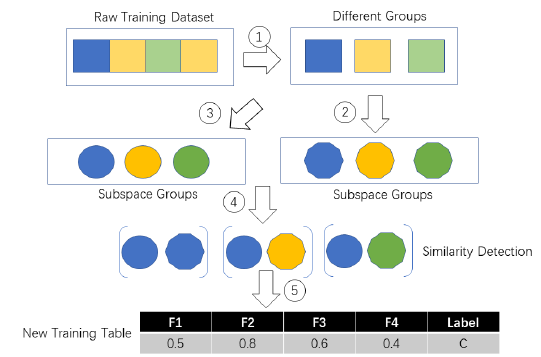
Figure 2. Process of transfering raw training dataset to new training